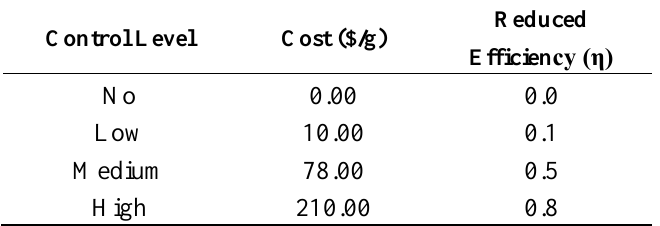
Table 2. Assumed control cost and reduced efficiency for each levels of control (adapted from [15]).